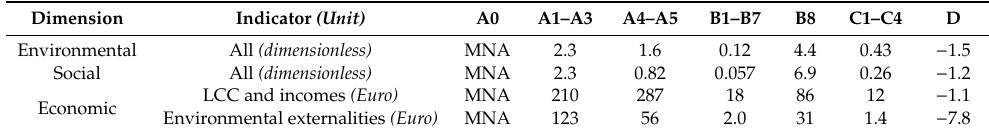
Table 5. Results for the CSF bridge design concept per life cycle stage aggregated on the dimension level (and on the indicator level for the economic dimension) for the functional unit. The results for the environmental and social dimensions are normalized and weighted, and the results for the economic dimension are summarized. Modules not assessed are abbreviated as “MNA”.